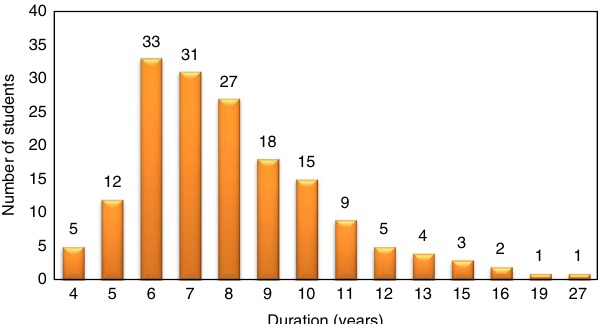
Figure 1. Number of graduates vs respective duration for the completion of the degree